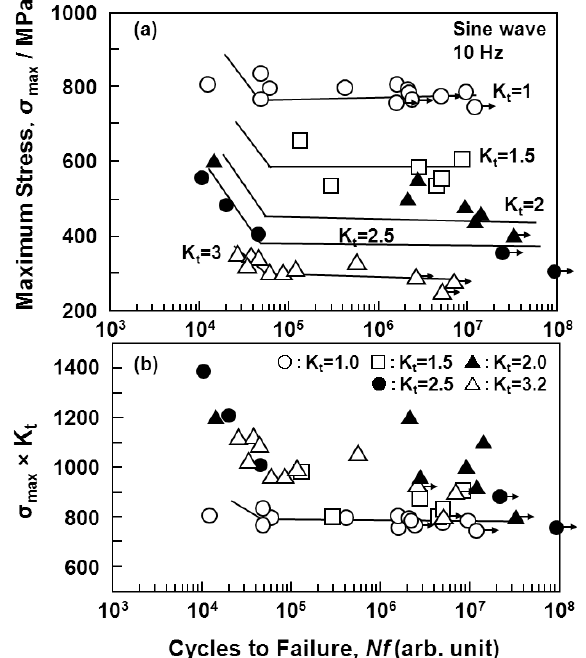
Figure 11. Effect of R-notch on S-N curves obtained by tension-to-tension fatigue test with annealed Ti-15Zr-4Nb-4Ta alloy rods. Effects of ( a ) stress intensity factor ( K and ( b ) σ × K on S-N max t